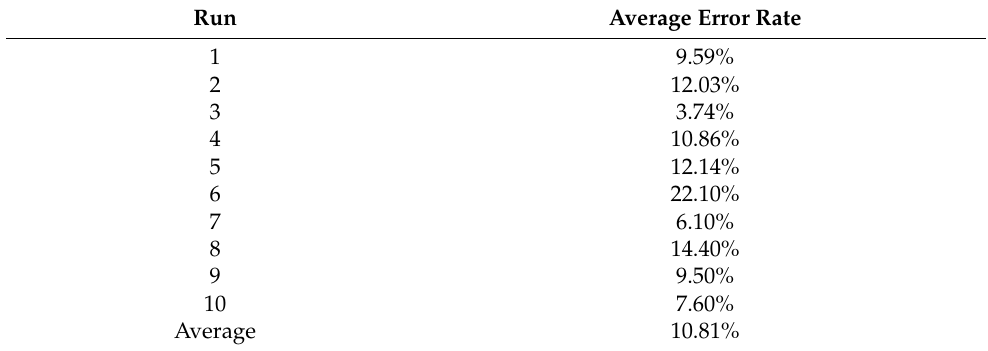
Table 8. The analysis of